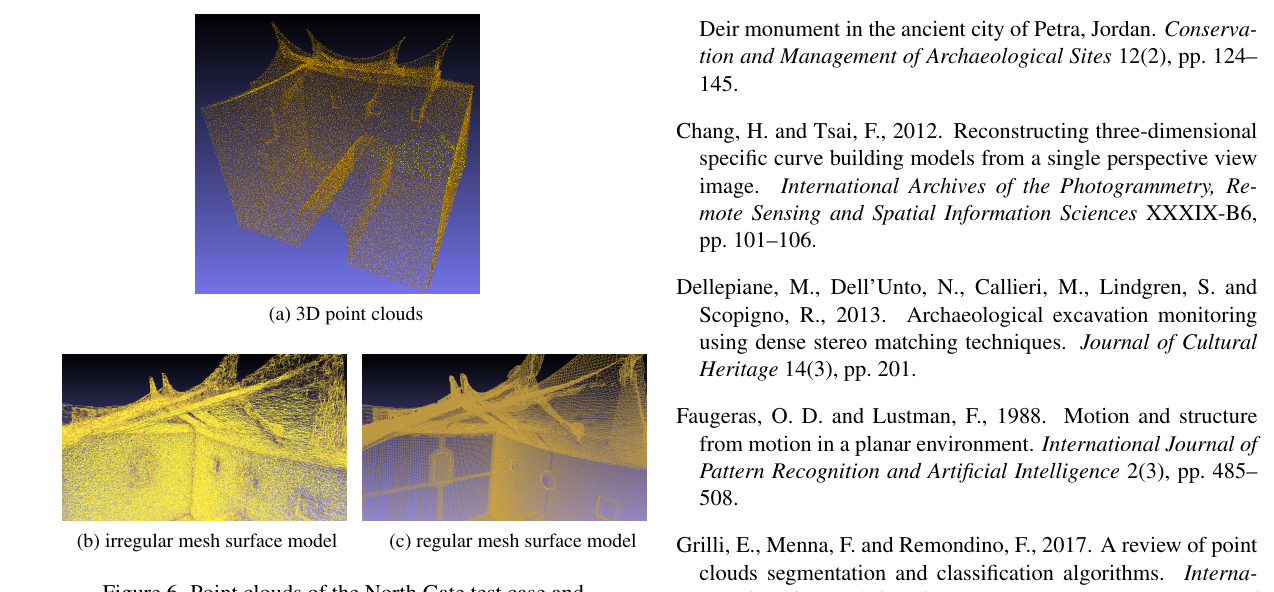
Figure 6. Point clouds of the North Gate test case and reconstructed mesh-based surface models.